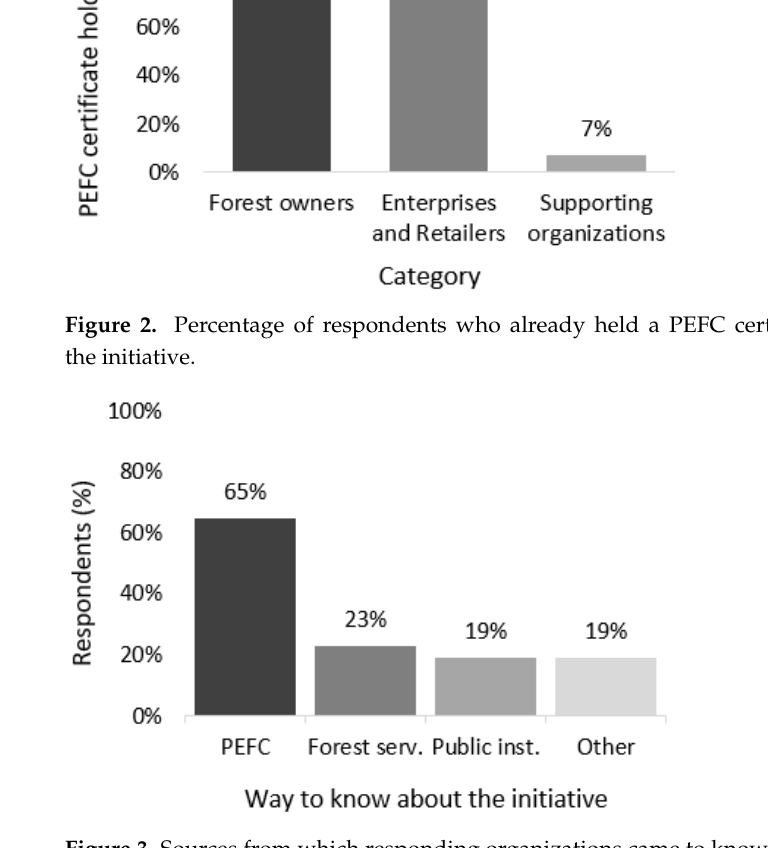
Figure 3. Sources from which responding organizations came to know about the PEFC fair supply chain (total is >100% because multiple responses were allowed).